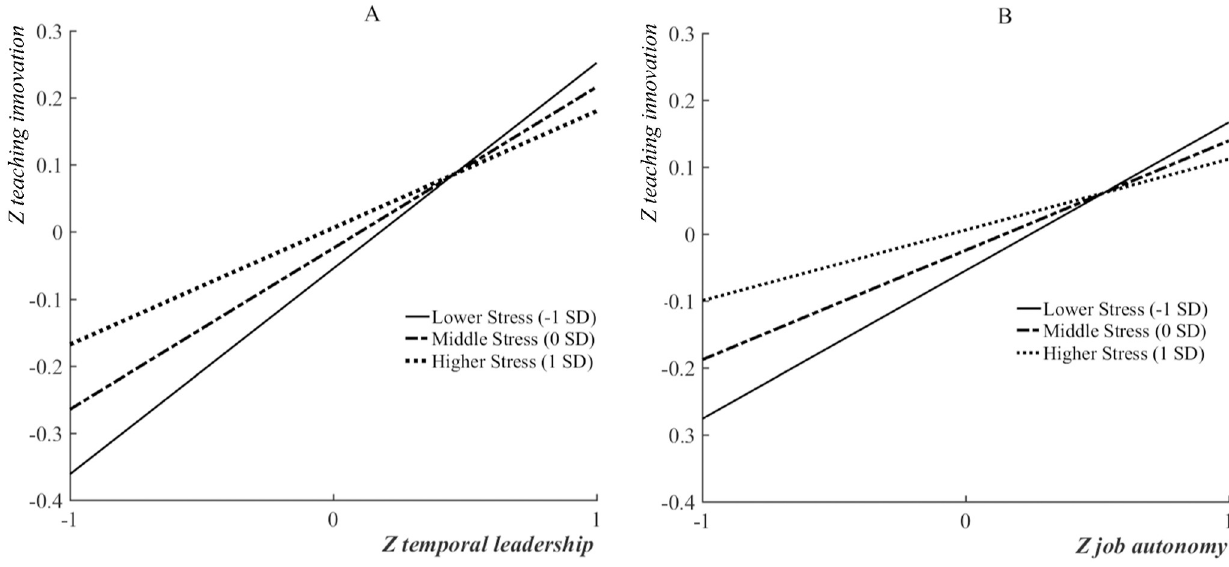
Fig 3. Simple slope analysis on the moderation of work